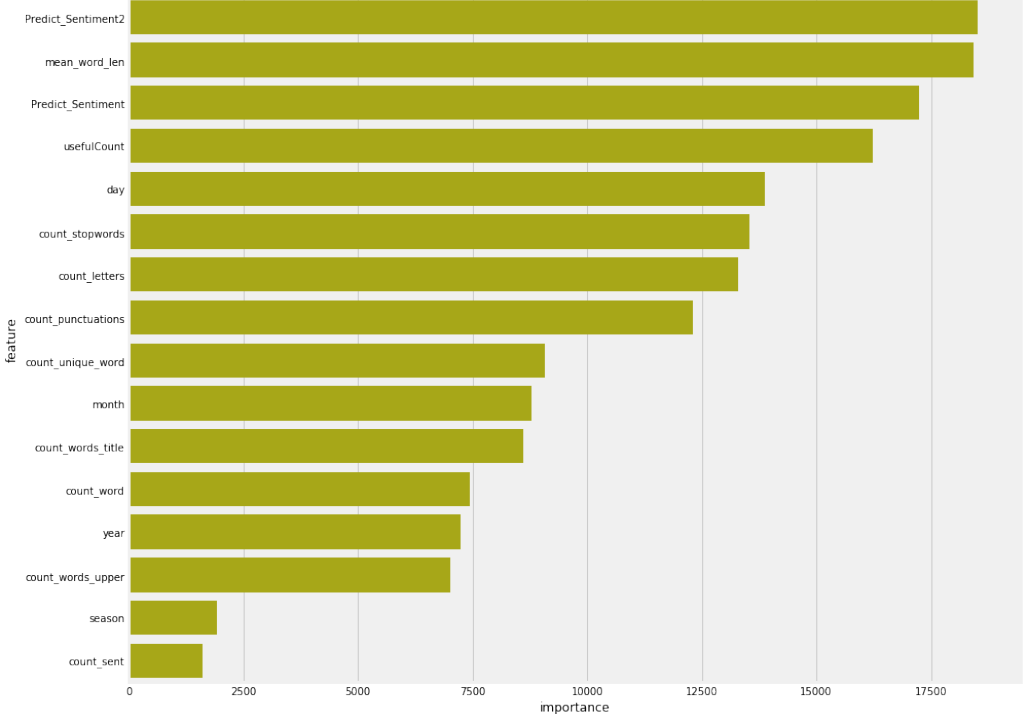
Figure 9. Important features with respect to high gradient using